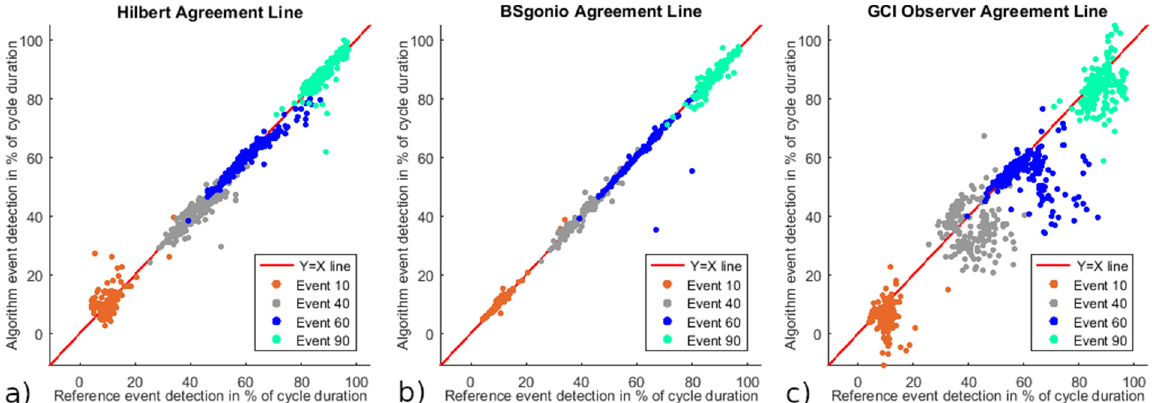
Figure 5. Reference event detections against Algorithm event detections for the three algorithms. The red line is the 45 ◦